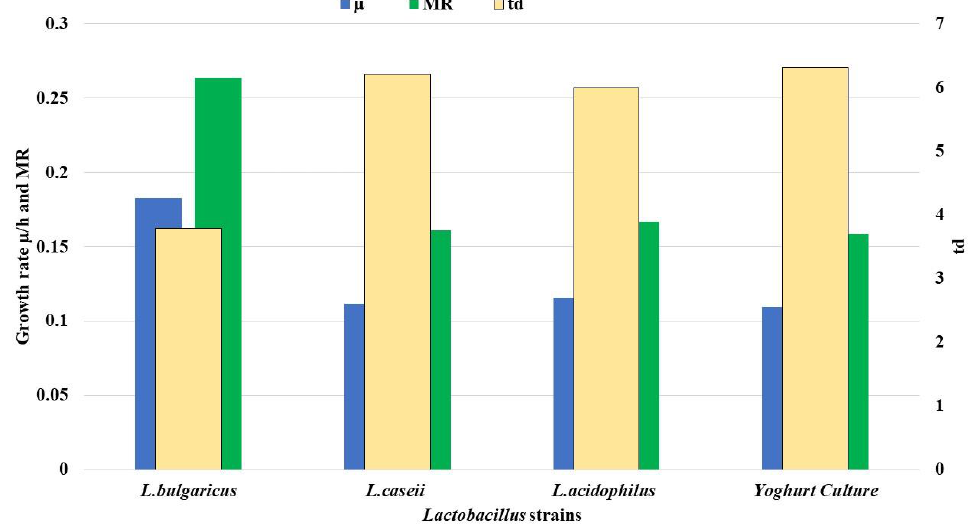
Figure 3. Growth kinetics ( μG, td, and MR ) of the three LAB strains against commercial yogurt culture (control) through the logarithmic growth phase during four hours of fermentation where, μ/h = specific growth rate, td = doubling time, and MR = multiplication rate.